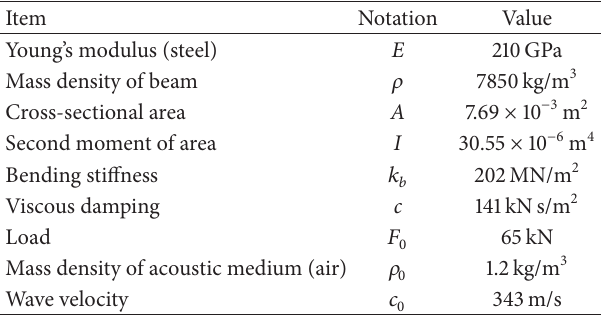
Table 1: Properties of the UIC60 rail, foundation, load, and acoustic medium [8].